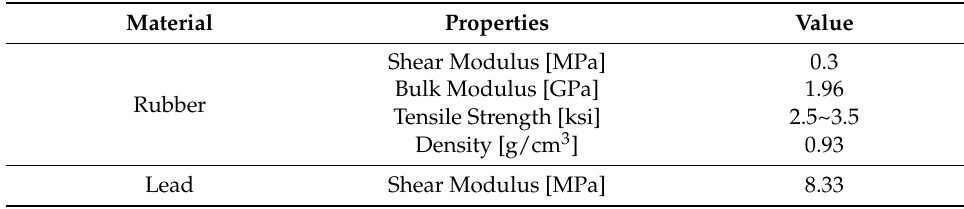
Table 2. Material properties of equipment LRB.